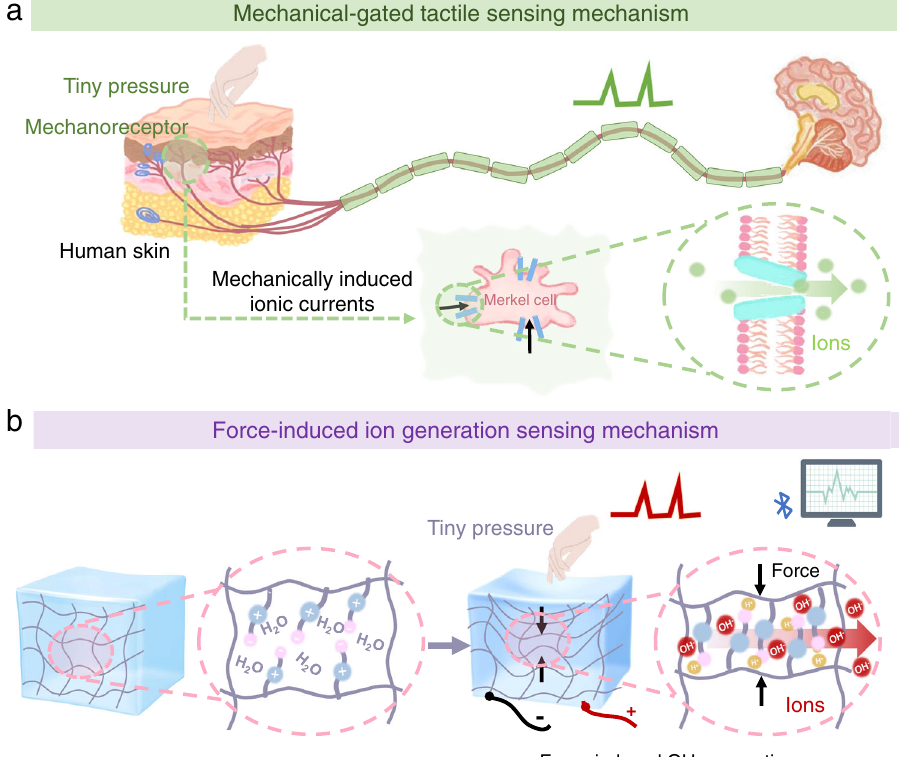
Fig. 1 | Schematics of (a) the mechanically gated tactile-sensing mechanism of human skin and (b) force-induced ion-generation sensing mechanism of the zwitterionichydrogel. In a ,themechanoreceptorsonhumanskinrespondtotiny pressures and mechanically gated ion channels (Piezo2 protein) open to allow transmembrane in fl ux of ions. In b , the zwitterionic PCBMA hydrogel deforms